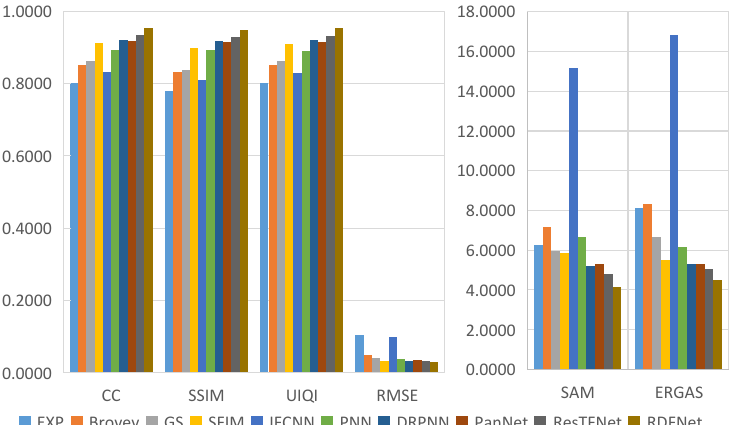
Figure 23. Quantitative metrics of testing dataset fusion results on Landsat-8 with reduced resolution.